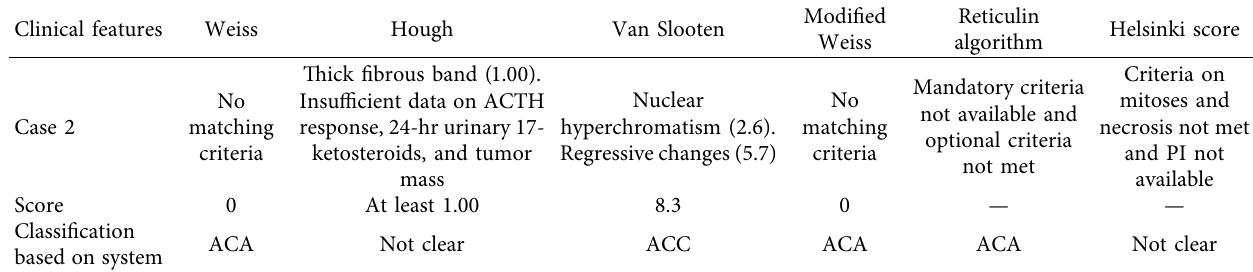
Table 5: Suggested pathological diagnosis of the adrenocortical tumor at the first operation of Patient B based on different classification systems on retrospective pathology review. Only the Van Slooten system would have classified the tumor as ACC unequivocally. Clinical